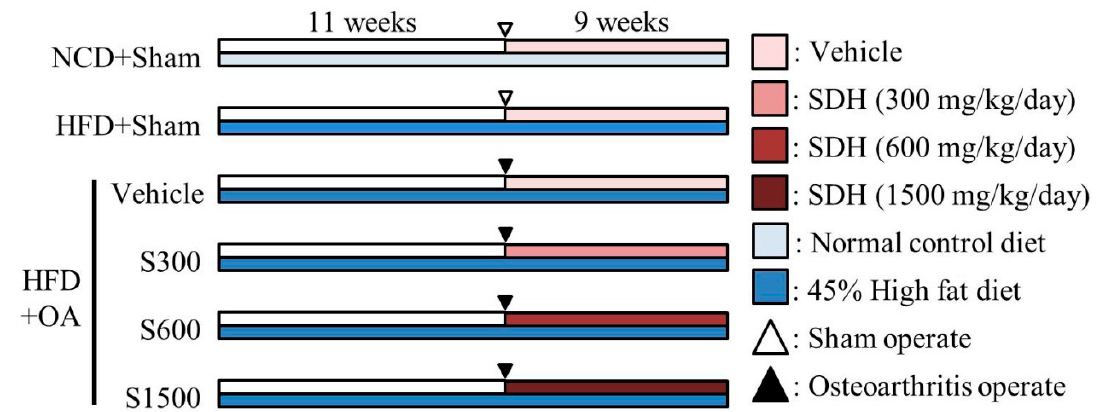
Figure 1. The experimental scheme used to induce obese and osteoarthritis, followed by administration of Shiikuwasha Extract.